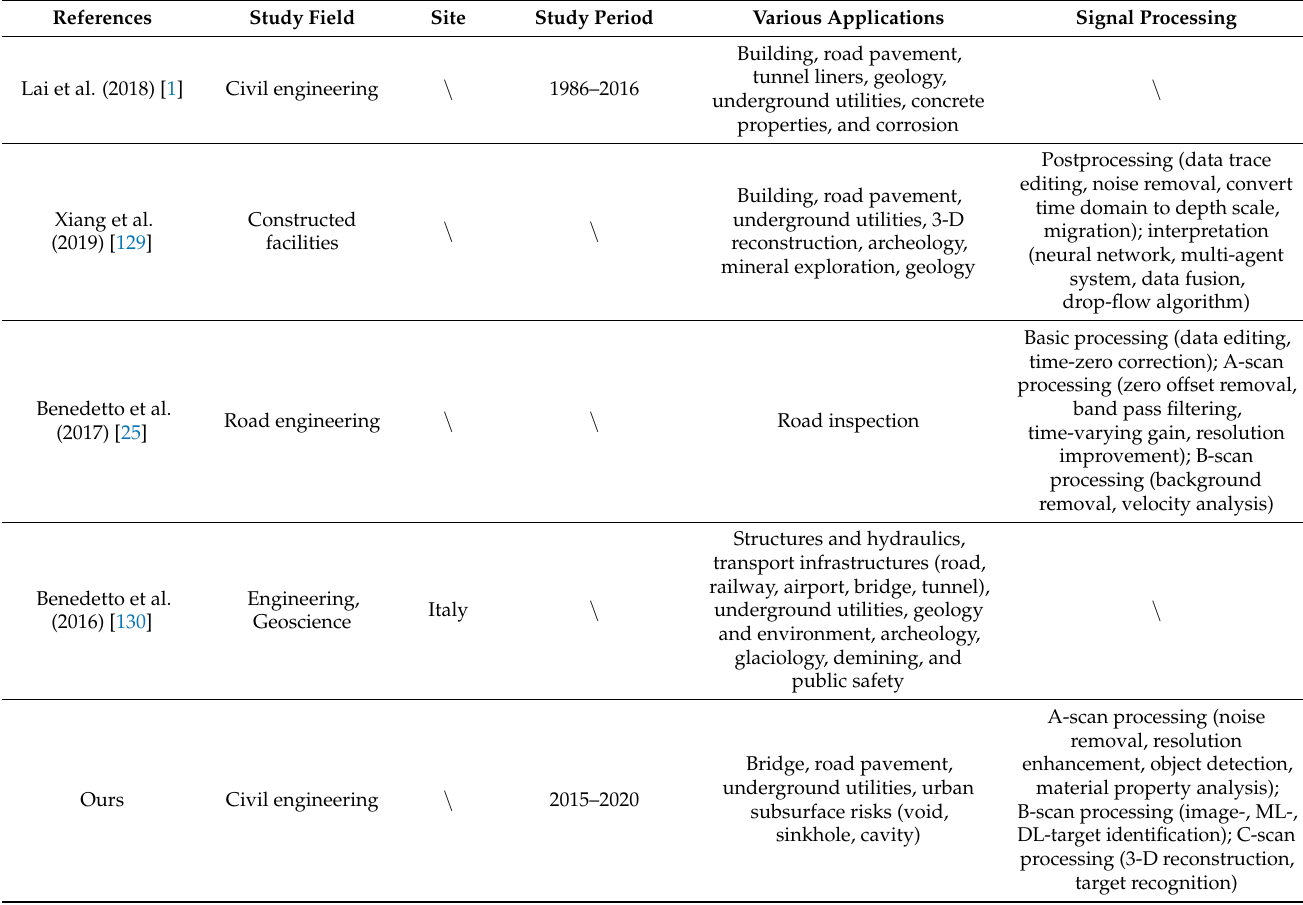
Table 5. Comparison between GPR review